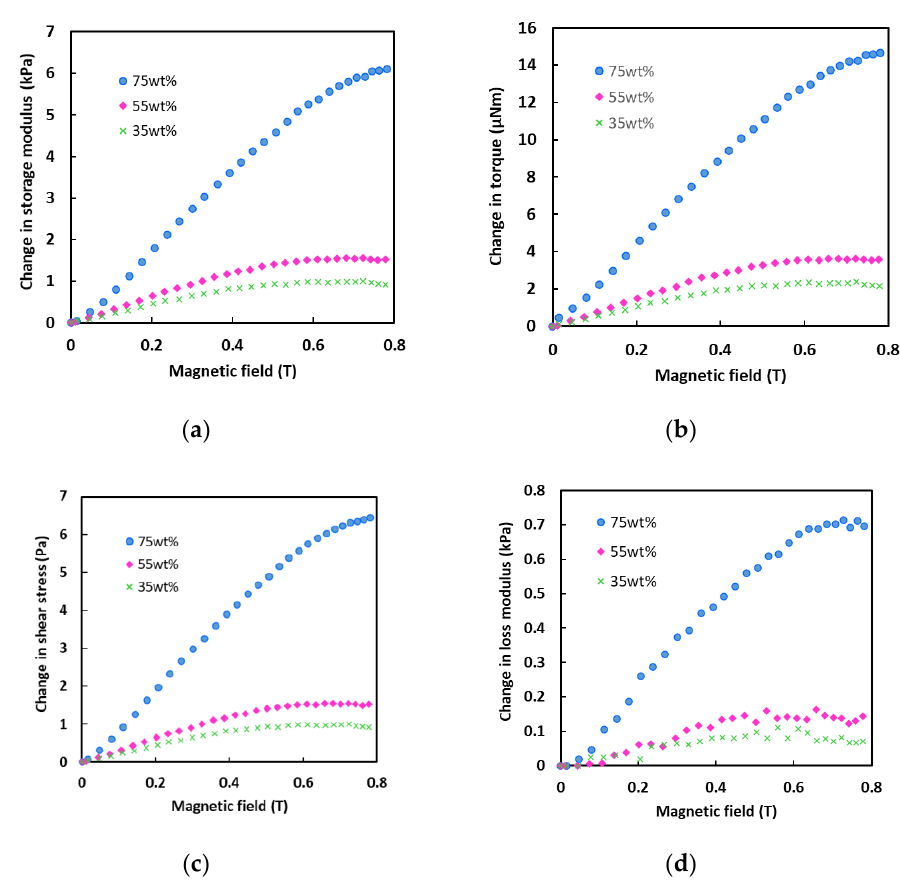
Figure 3. Change in ( a ) storage modulus, ( b ) torque, ( c ) shear stress and ( d ) loss modulus of magnetoactive (MA) foams versus magnetic field at 0.001% shear strain and frequency of 1 Hz.